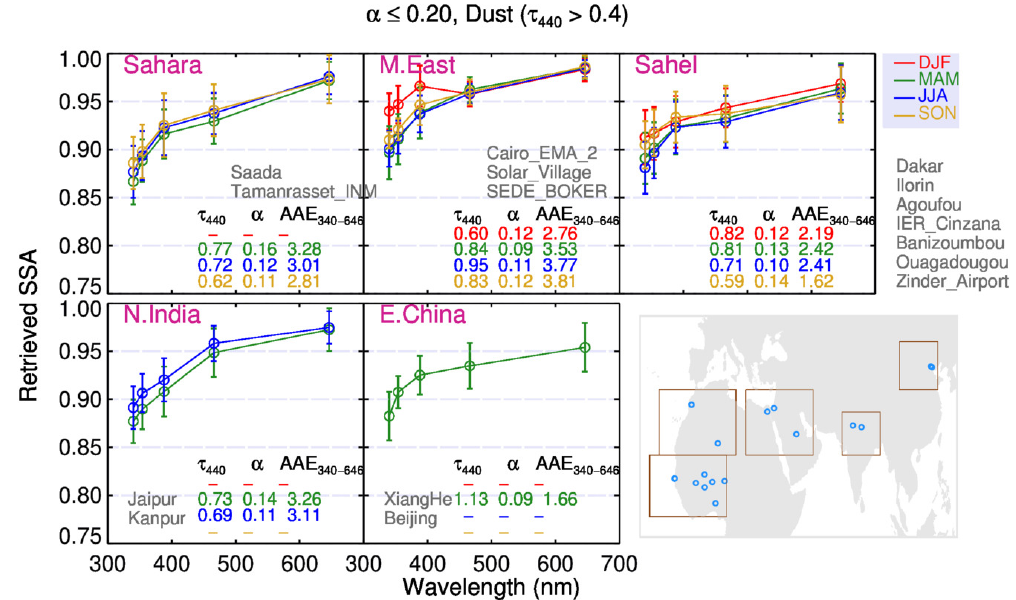
Figure 13. Seasonal average of spectral aerosol SSA derived for observations with τ 440 > 0 . 4 over regions dominated by coarse-mode dust aerosols. The error bars represent the standard deviation of the